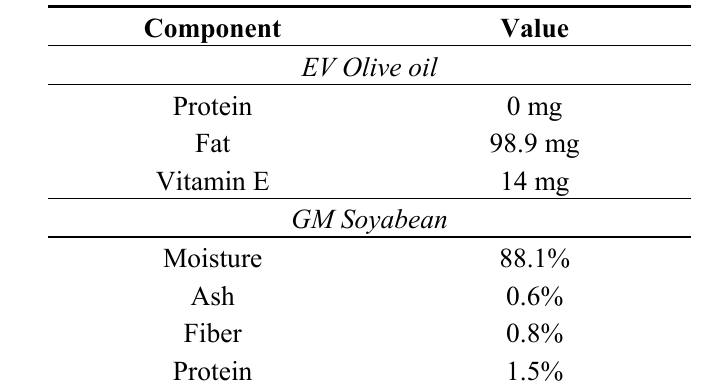
Table 2. Chemical composition of extra virgin (EV) olive oil and genetically modified (GM) soyabean.